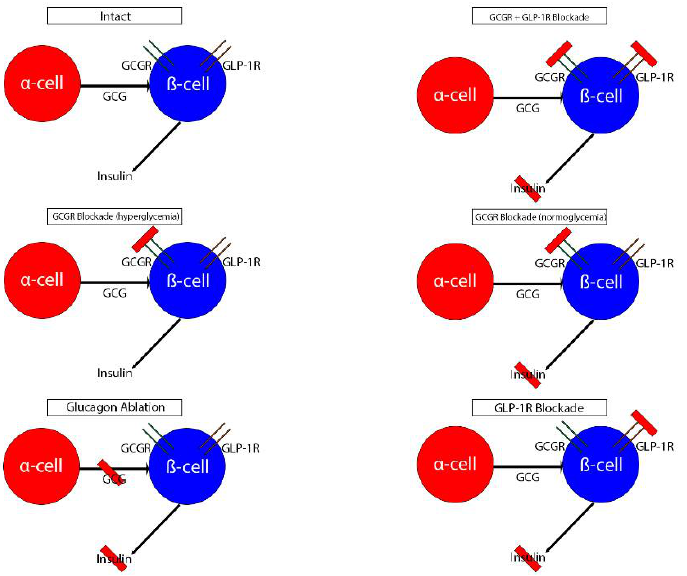
Figure 1. Visual summary of intraislet crosstalk between glucagon and insulin signaling. Abbrevia- tions: GCG glucagon; GCGR glucagon receptor; GLP-1R glucagon-like peptide-1 receptor.